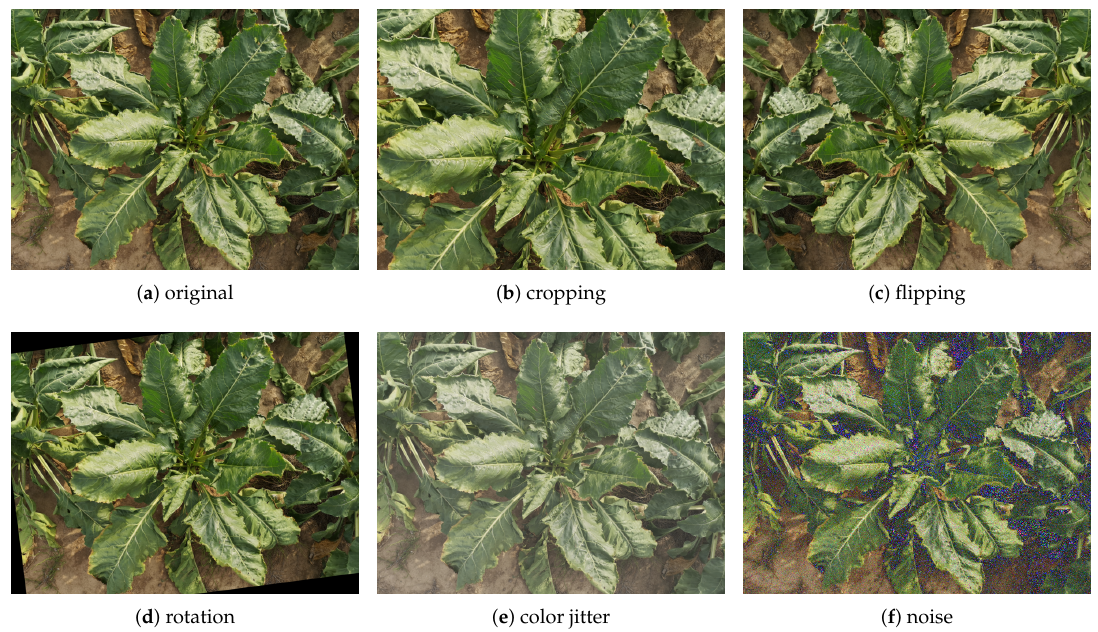
Figure 6. Example images after applying data augmentation techniques. Note that the noise value is exaggerated for better